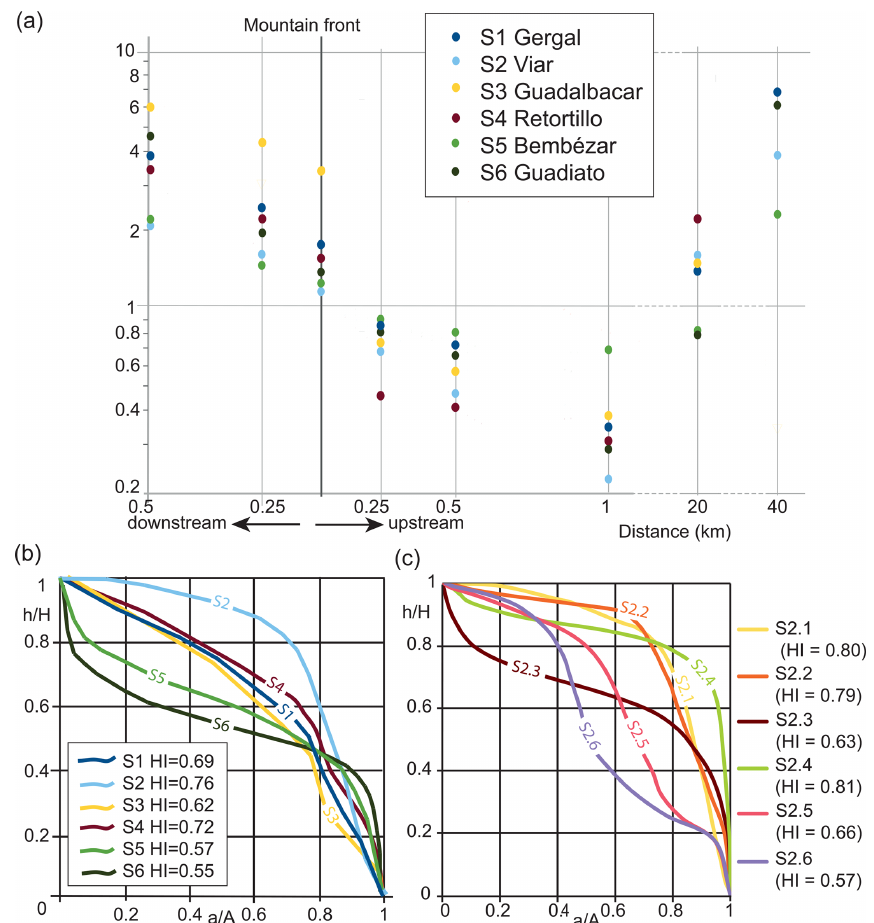
Figure 5. Geomorphic indices. (a) V f values for the main streams of S1 to S6 that are upstream and downstream of fault-related mountain fronts (see Fig. 7 for the fault location). (b) Hypsometric curves and hypsometric integral (HI) values for the same streams as in panel (a) . (c) Hypsometric curves and HI for sub-basins on the right slope of the River Viar valley (located in Figs. 1b and 2a). The altitude base and reference system are as in Fig.